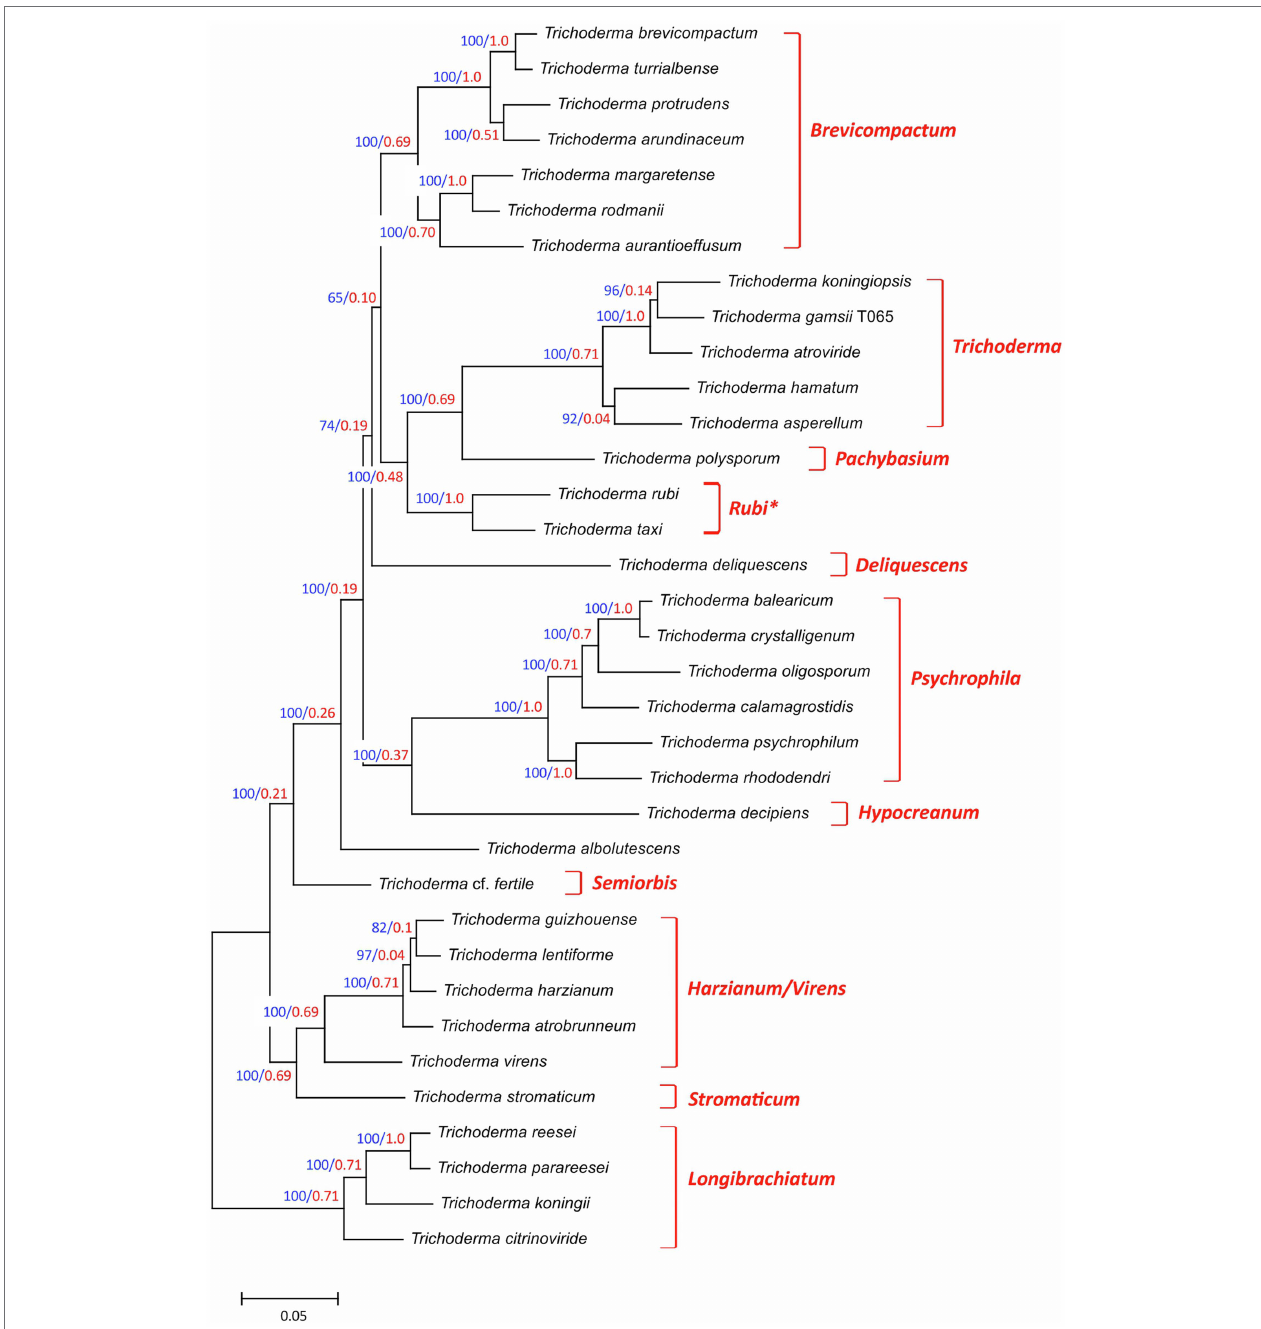
FIGURE 1 | Species tree for the 35 Trichoderma species included in this study. The tree was inferred from full-length exon sequences of 20 housekeeping genes (= 52,200 total sites; Supplementary Table S2 ) as described in the Methods section. On each branch, numbers in blue type are bootstrap values based on 1,000 pseudoreplicates, and numbers in red type are internode-certainly values. The previously described subgeneric lineages (Kubicek et al., 2019) are indicated to the right of the tree. In the tree, the clade consisting of T. rubi and T. taxi has been assigned to a new lineage that we designated Rubi . T. albolutescens has not been assigned to a lineage. GenBank accession numbers of housekeeping gene sequences that were used in this analysis are included in Supplementary Table S4a (Note that In the table GenBank accession numbers are provided only for housekeeping gene sequences retrieved from genome sequences generated during the current